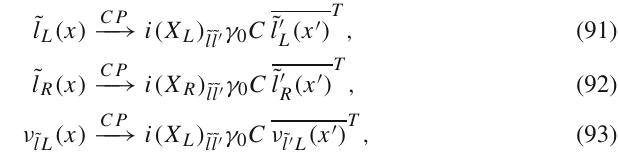
0 . 538 ( 0 . 554 ) for NO (IO)] (current best fit values) and the relative 1 σ uncertainty of 0 . 7% [3%] expected from JUNO [DUNE and T2HK]. = 0 . 307 [sin 2 θ bf = See text for further details. (From Ref. 12 23